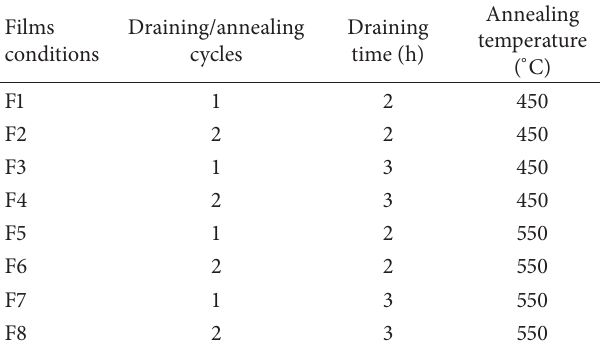
Table 1: Matrix of the 2 3 factorial experimental design for film formation, in natural